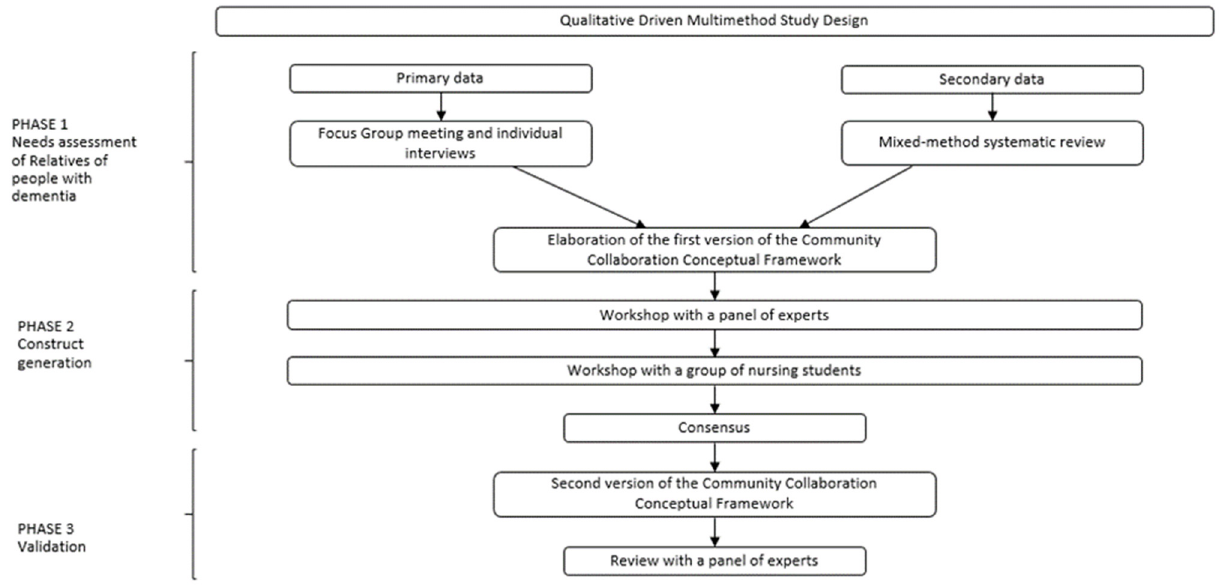
Figure 1. Process adopted to develop and validate the Community Collaboration Framework